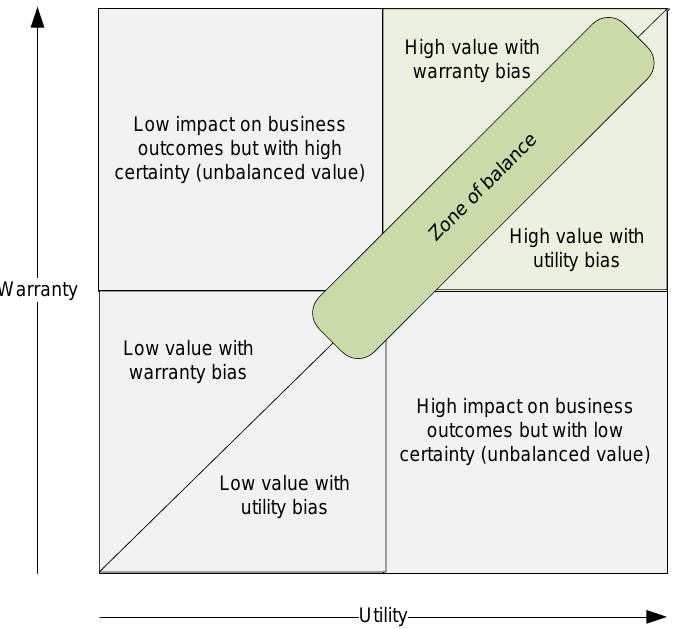
Figure 2 Value communicated in terms of utility and warranty. Adapted from (Cartlidge, Hanna, Rudd, Macfarlane, Windebank, & Rance,